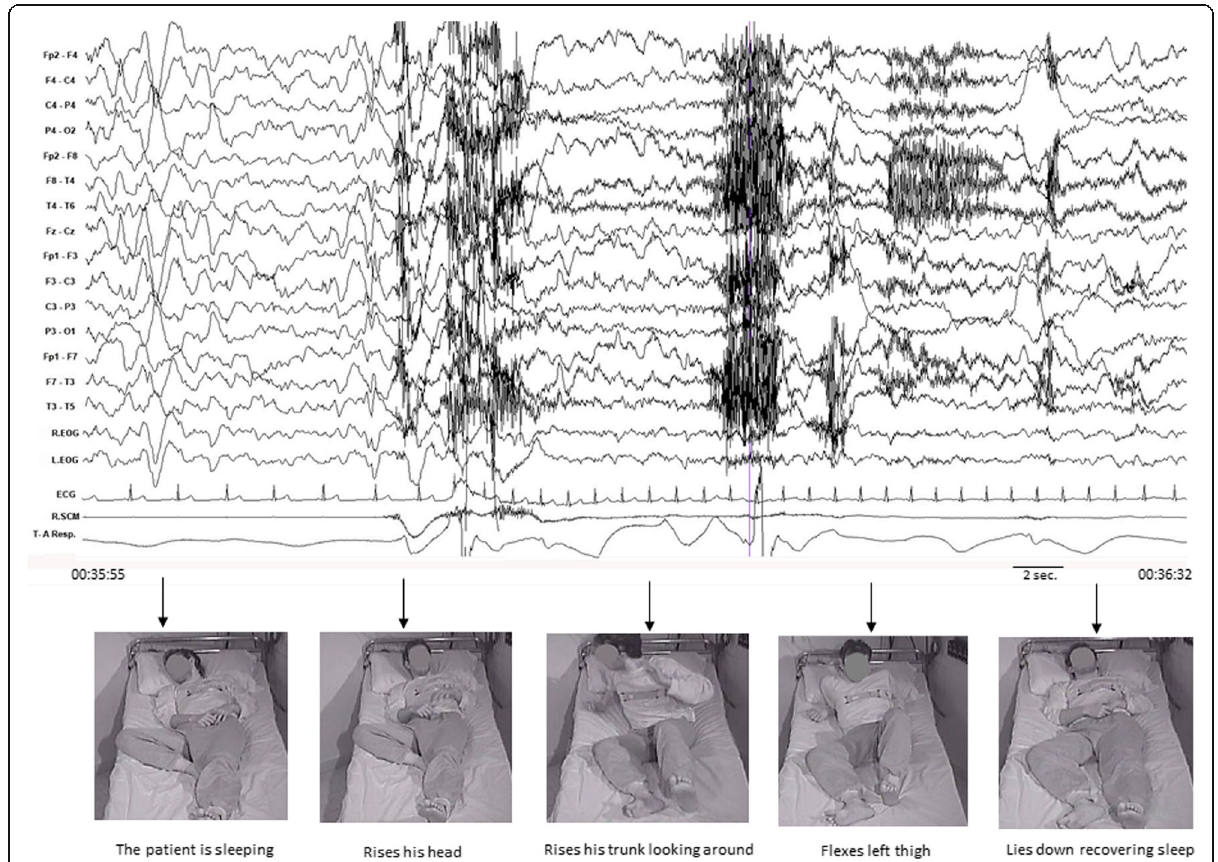
Fig. 2 Typical Confusional Arousal episode. On the top: polysomnographic tracing. The episode arises during Slow Wave Sleep. Motor onset corresponds to an EEG artifact followed by the appearance of theta-delta activity on the anterior regions and of alpha and beta activity on the posterior regions. On the bottom: photographic sequences of the episode. The patient is sleeping in a supine position, raises his head, raises his trunk looking around; lies down and flexes the left thigh; lies down recovering